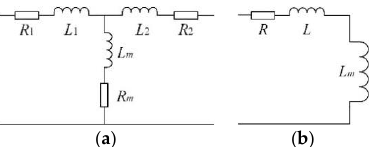
Figure 2. ( a ) T type; and ( b ) Γ type equivalent circuits of the transformer. L 1 : Leakage inductance of the low-voltage winding; L 2 : leakage inductance of the high-voltage winding; L : leakage inductance; R: winding resistance; R 1 , R 2 , R m : winding resistance of the transformer; L m : magnetizing inductance; L m : magnetizing inductance of the